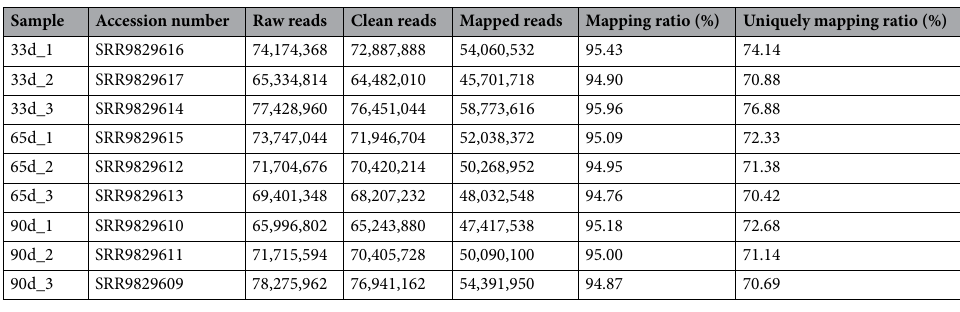
Table1. Summary of data from